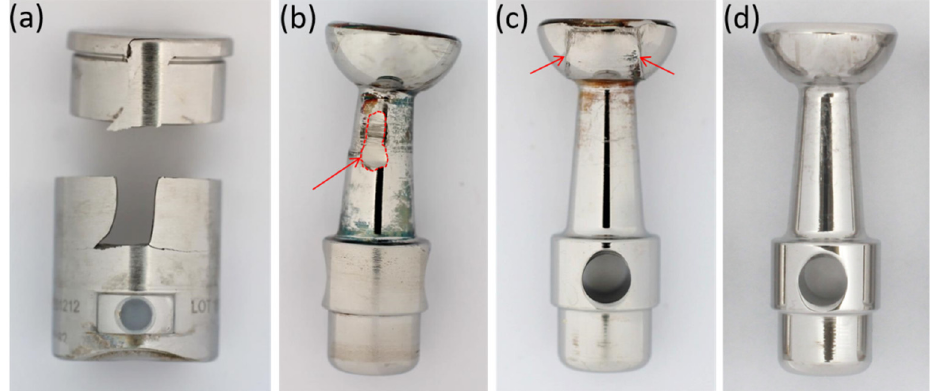
Figure 5. Damage occurring at couplings: ( a ) broken coupling sleeve, ( b ) bent piston with area of abrasive wear at piston stem (encirculated area, arrow), ( c ) piston head with zones of planar abrasion, the arrows mark the created edge between the worn and the unworn zones, ( d ) piston without noticeable planar abrasion.